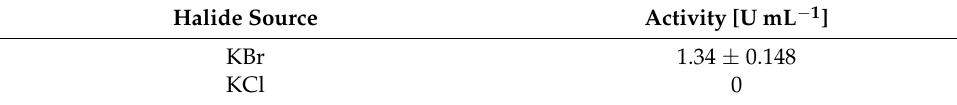
Table 2. Halide acceptance of VPO-RR